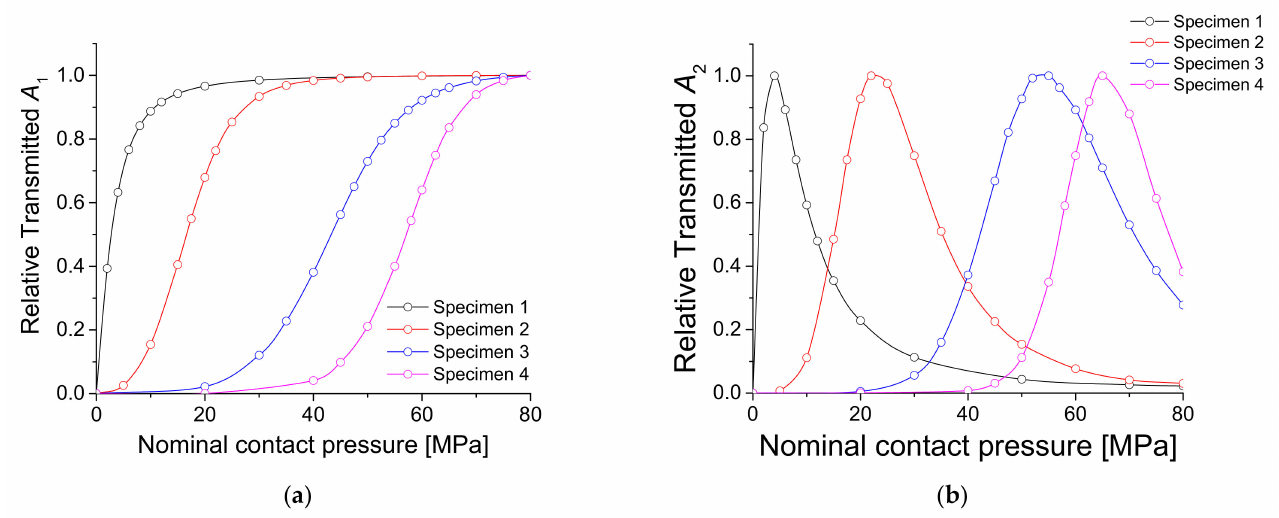
Figure 5. Results of FEM simulations for four specimens: ( a ) A 1 and ( b ) A 2